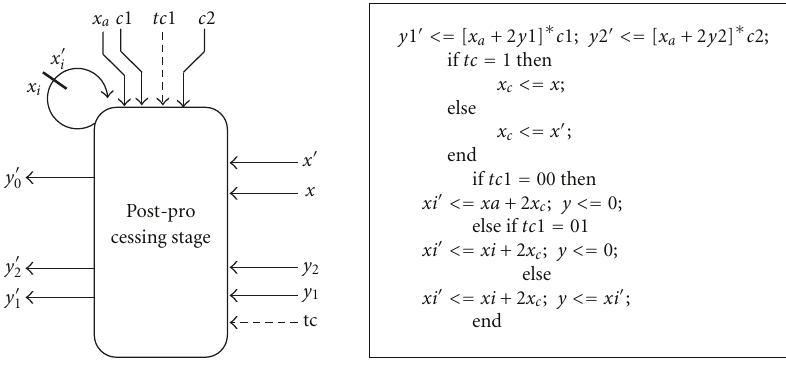
Figure 4: Functionality of a post-processing element in Figure